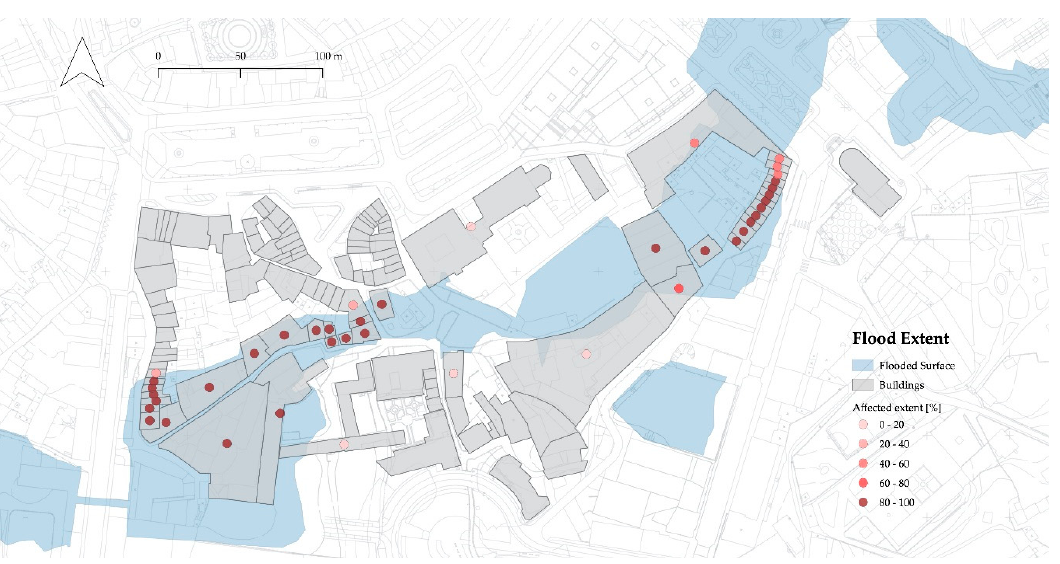
Figure 4. Flood inundation map for the adopted 100-year peak flow